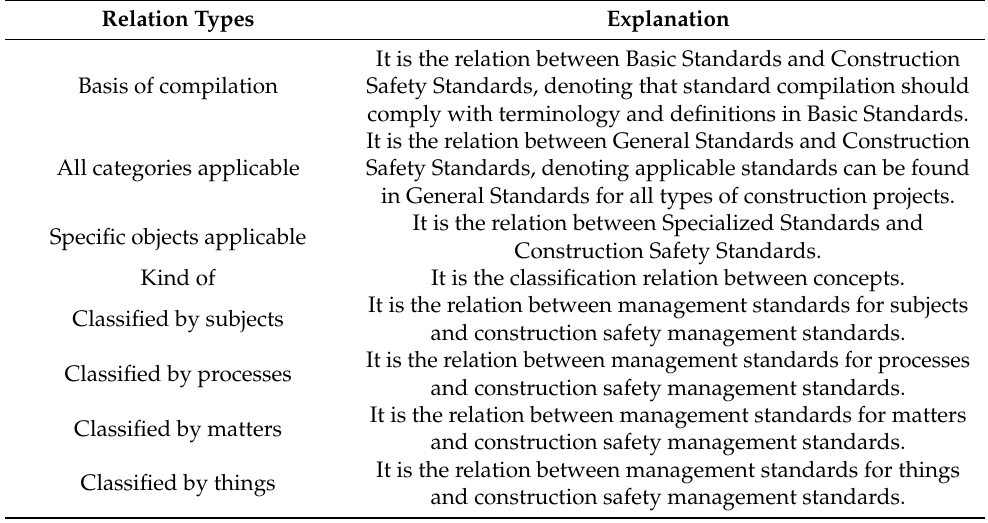
Table 1. Concept relationships of construction safety standard knowledge